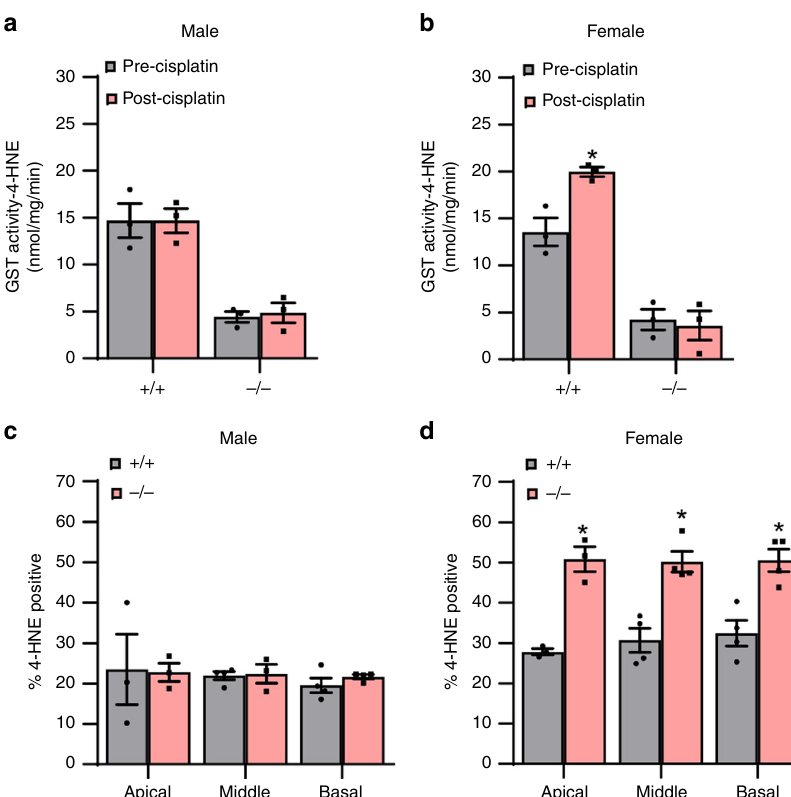
Fig. 5 Assessment of GST activity. a , b GST activities toward 4-HNE were measured in the cytosol of inner ear tissues from male ( a ) and female ( b ) Gsta4 + / + and Gsta4 − / − mice prior to and after cisplatin treatment. n = 3, * p <0.05 vs. precisplatin (two-way ANOVA). Error bars represent±s.e.m. c , d 4-HNE-positive SGNs were counted and quanti fi ed in the apical, middle, and basal regions of cochlear tissues from male ( c ) and female ( d ) Gsta4 + / + and Gsta4 − / − mice after cisplatin treatment. The quanti fi cation shows a mean of at least three independent experiments ( n = 3), * p <0.05 vs. + / + (two-way ANOVA). Error bars represent±s.e.m. Source data are provided as a Source Data fi le